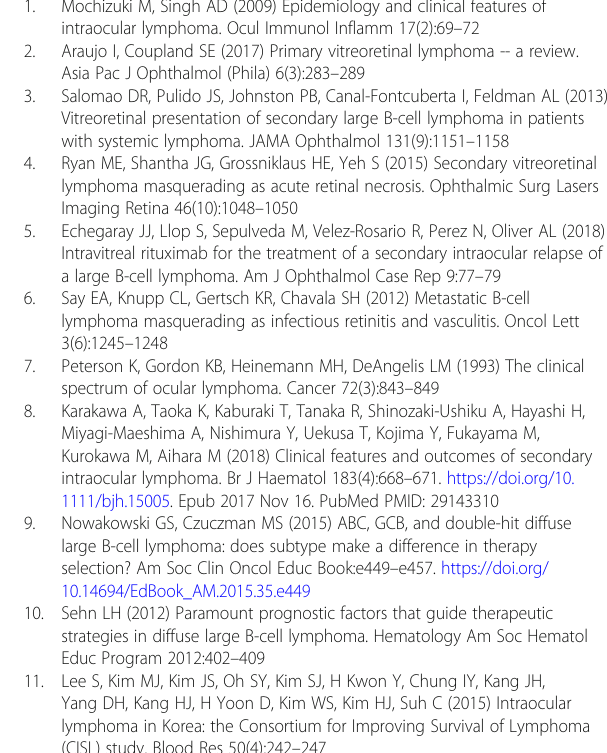
Fig. 6 Post-operative fundus photography and optical coherence tomography of the left eye. Left eye status post pars plana vitrectomy and intravitreal injections with marked reduction of exudative retinal detachment and subretinal fluid with the presence of diffuse peripheral exudation as seen on fundus photography montage ( a ) and OCT ( b